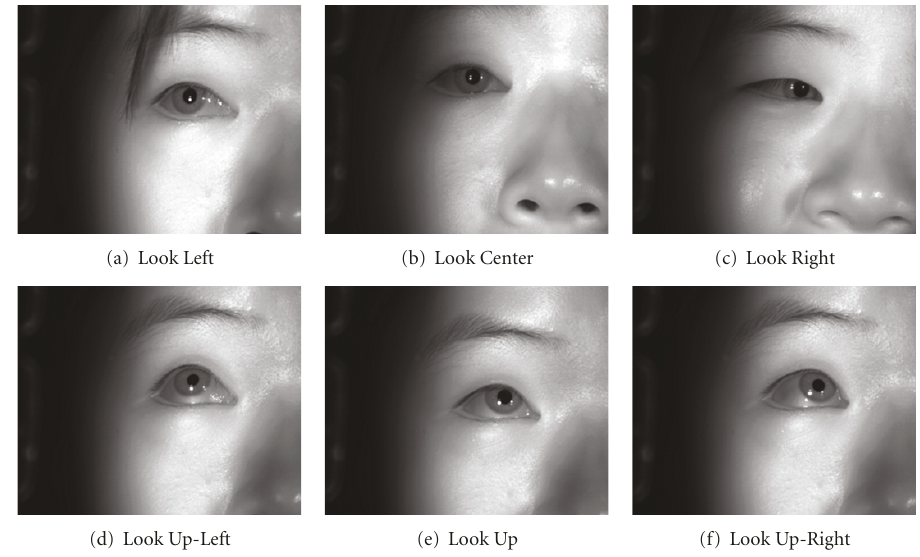
Figure 11: IUPUI Remote Iris Image Database: Multiple